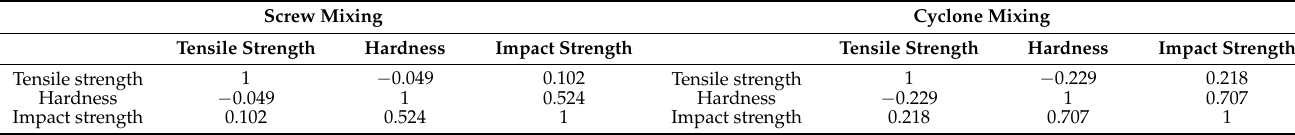
Table 5. Matrix of the correlation coefficient.